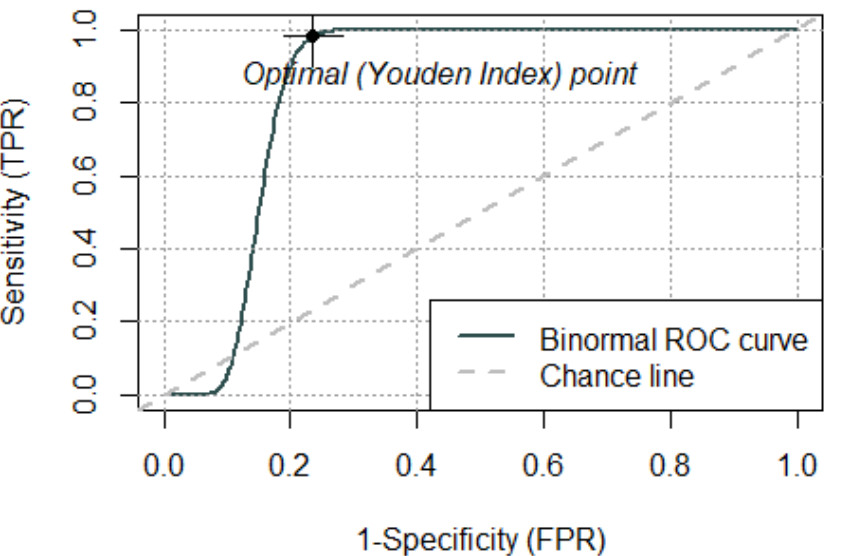
Figure 2. Receiver operating characteristic analysis yielded an area under the curve of 0.847.